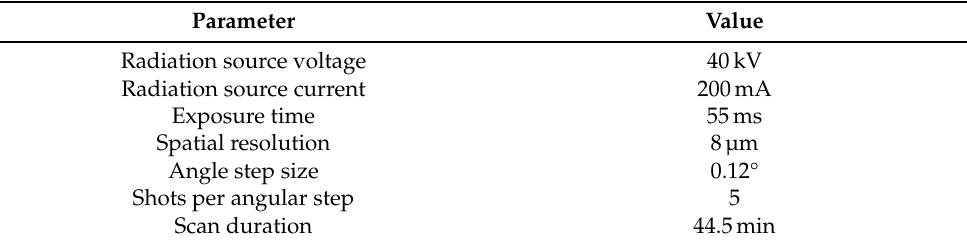
Table 2. Parameters for the here presented